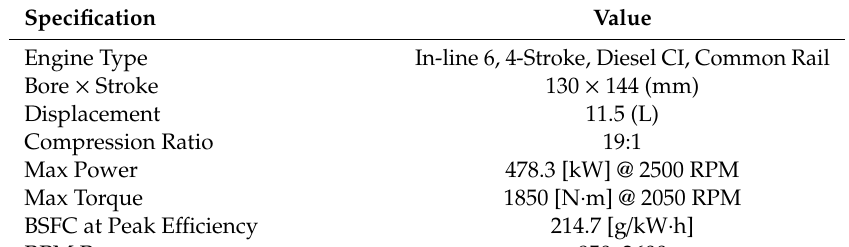
Table 1. Modelled engine specifications.